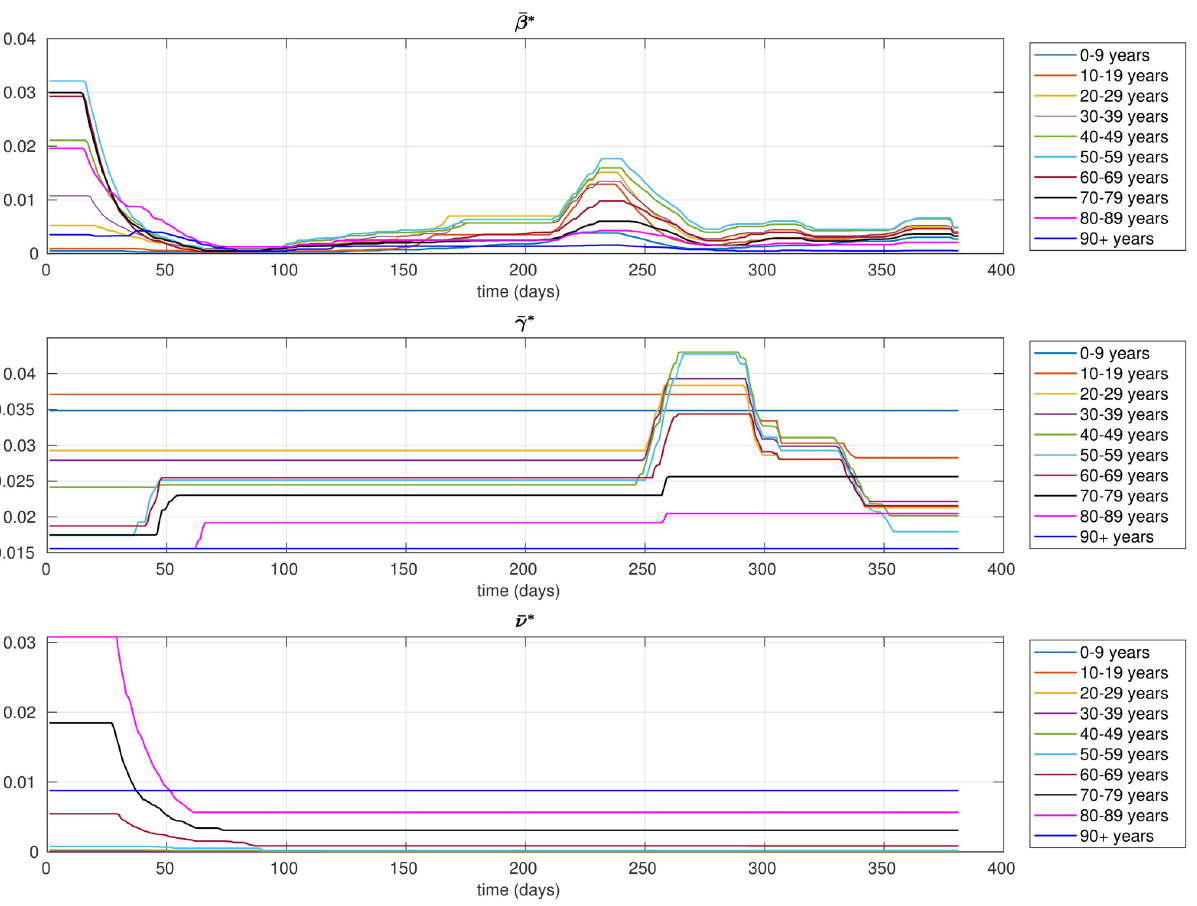
Fig 2. Optimal parameters identified by the proposed model. The percentage of non-zero elements in E elements in E d � γ � is 3%, and the percentage of non-zero elements in E k